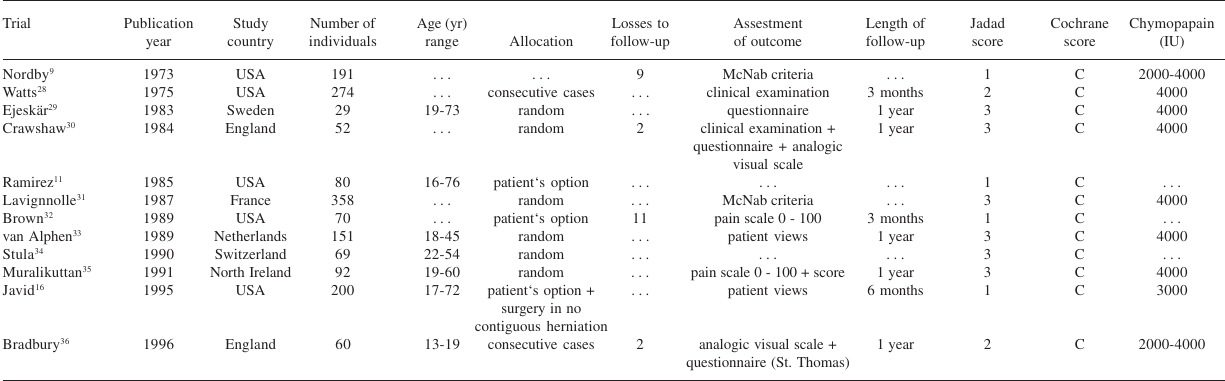
questionnaire (St.